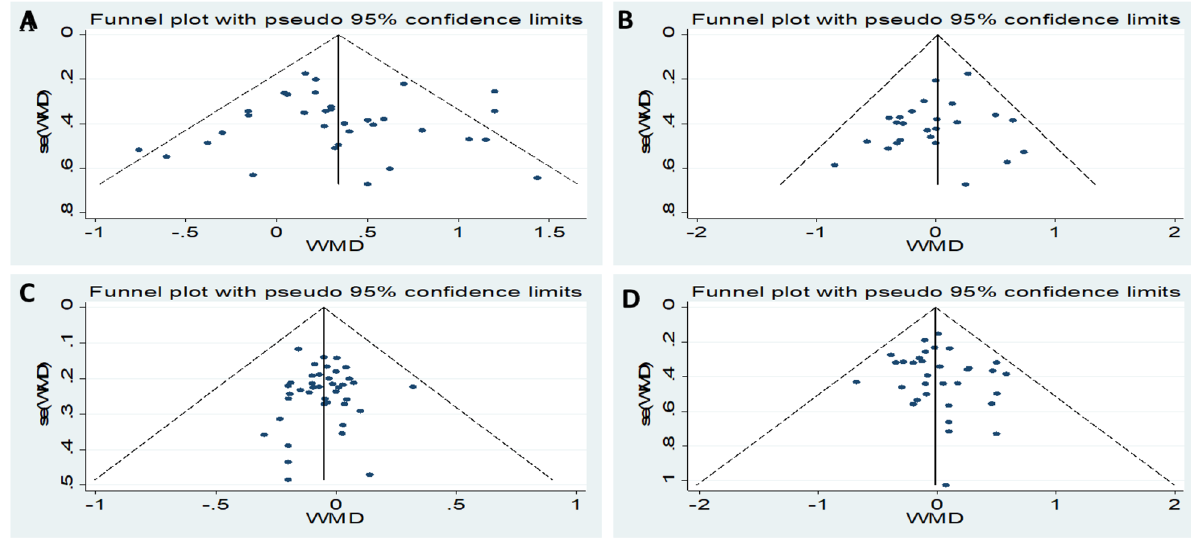
Figure 6. Publication bias funnel plots of the MD for ( A ) TG, ( B ) TC, ( C ) HDL, and ( D ) LDL and DN.